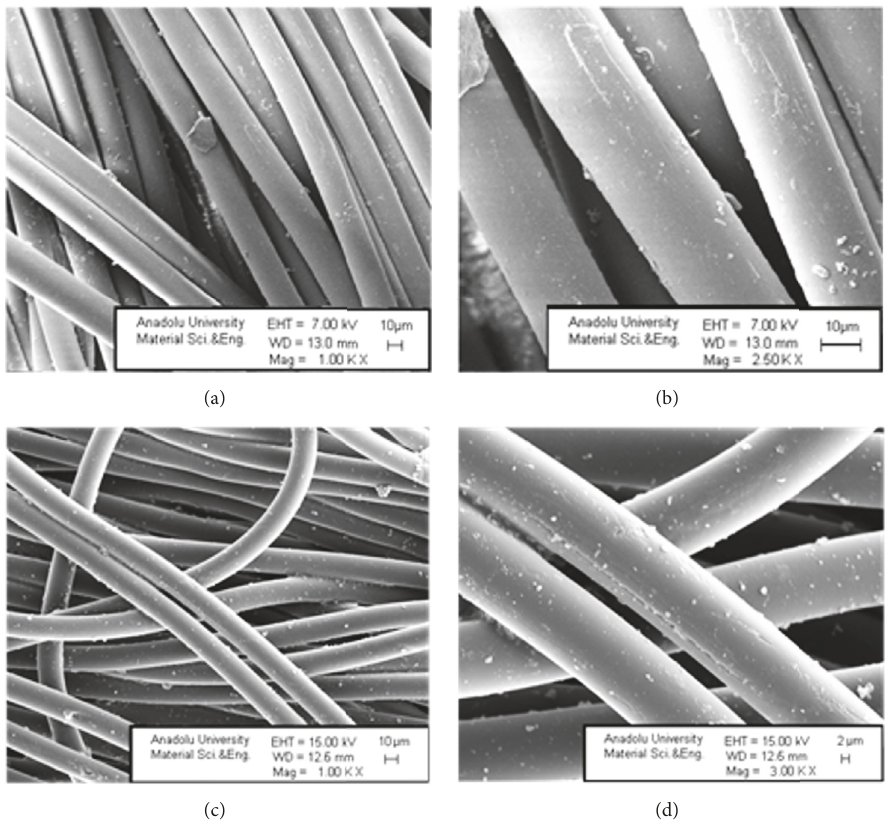
Figure 7: SEM test results of fabric samples. (a) PEK (1,000X); (b) PEK (2,500X); (c) PEK-Z25 (1,000X); (d) PEK-Z25 (3,000X).